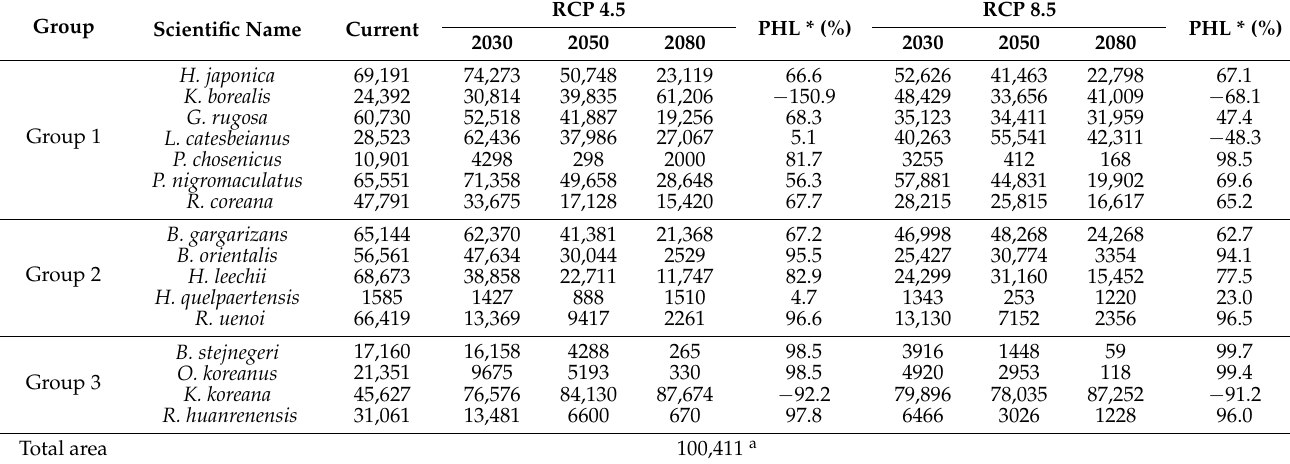
Table 4. Estimating the suitable habitat area of amphibians per habitat characteristics. (unit: km 2